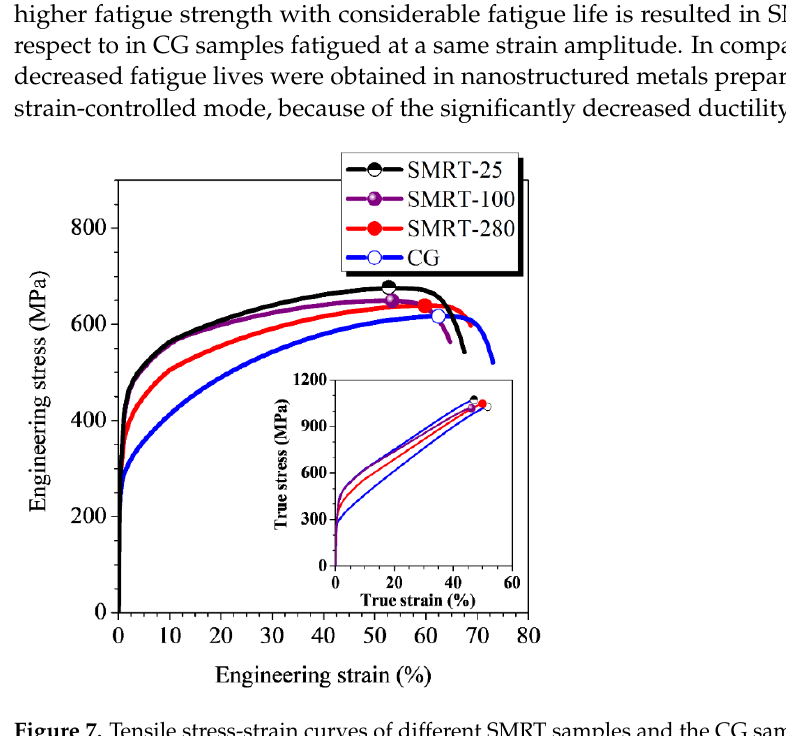
Figure 7. Tensile stress-strain curves of different SMRT samples and the CG sample. Insert shows the true stress-strain curves.